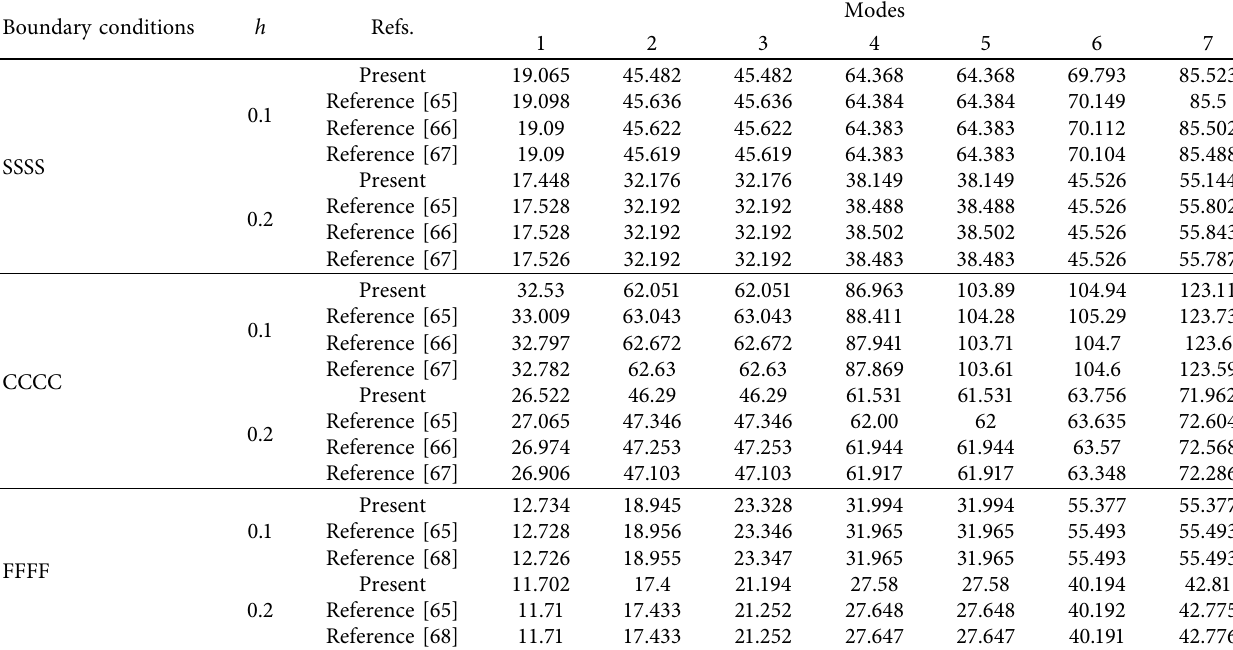
Table 3: Comparison of dimensionless frequencies of non-stepped isotropic plate.